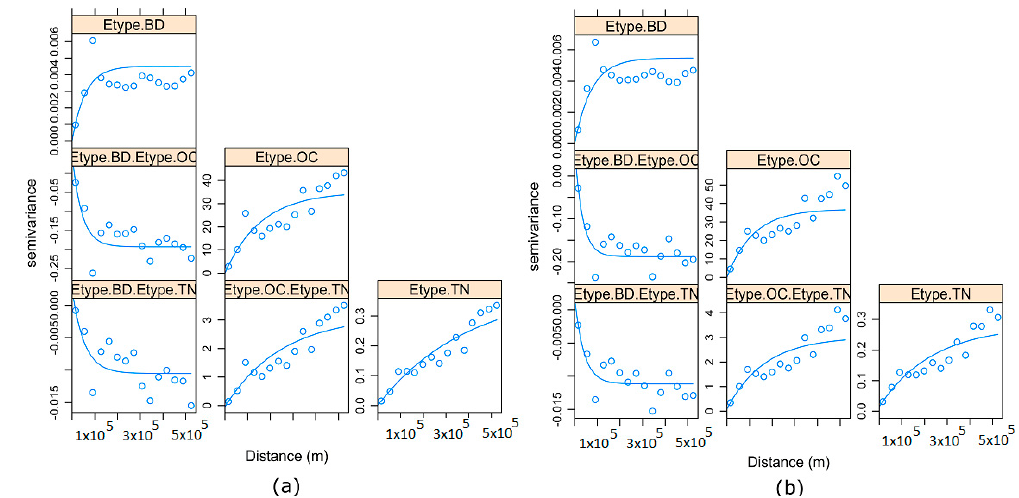
Figure 11. Direct and cross-experimental variograms for average realizations (E-type) for ( a ) MAF and ( b ) ICA (Etype.BD = Average of 100 realizations for bulk density (g/cm 3 ); Etype.OC = average of 100 realizations for organic carbon (g/kg); Etype.TN = average of 100 realizations for total nitrogen (g/kg). Semivariance is expressed in units of each variable.